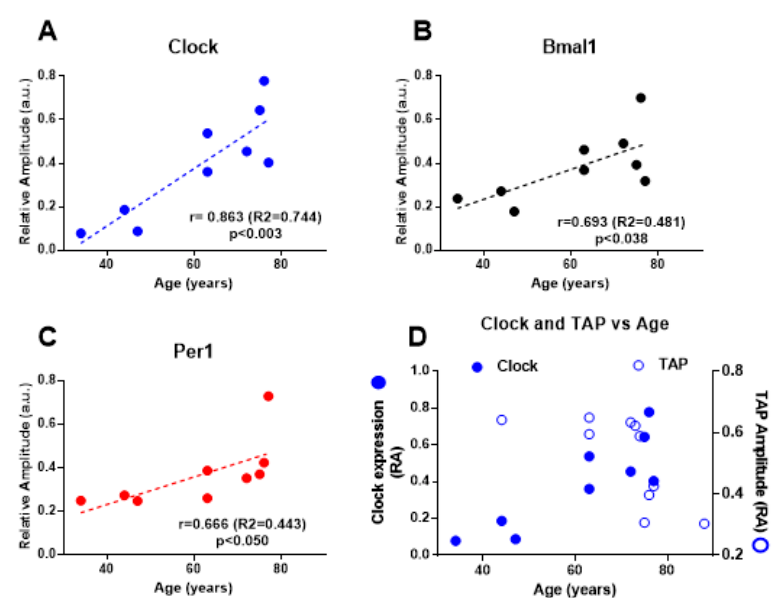
Figure 4. Aging increases the relative amplitude of the clock genes circadian rhythm in colon muscle. ( A – C ) Relative amplitude of the circadian rhythms of Clock , Bmal1 and Per1 expression was calculated for individuals of different ages. r: Pearson correlation coefficient; R2: determination coefficient; p : correlation significance. ( D ) Comparison of the age-related changes in the systemic circadian rhythm (TAP relative amplitude) and the colonic clock gene rhythm ( Clock relative amplitude) in the same individuals.